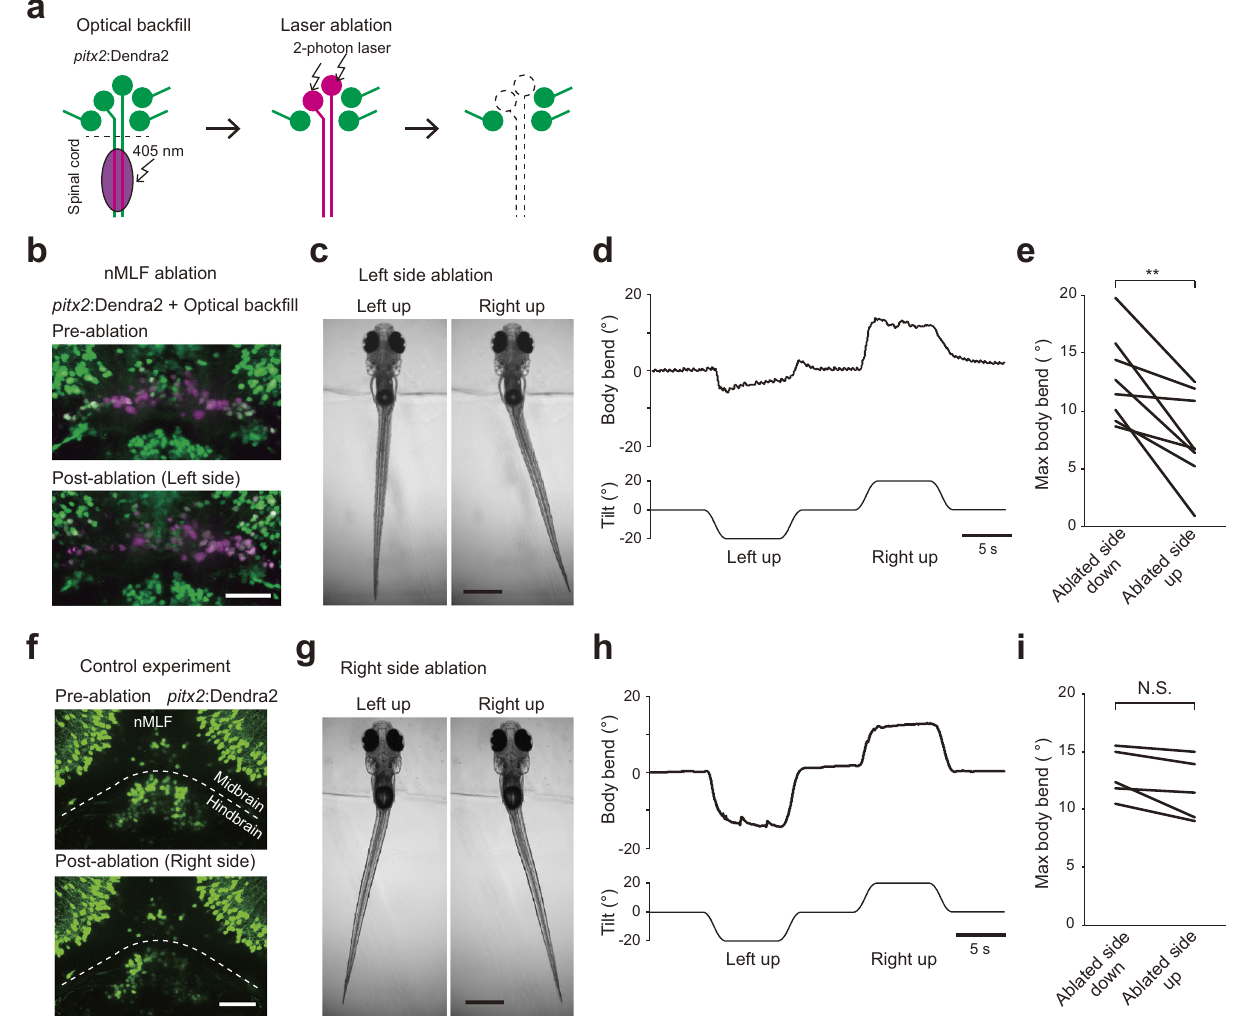
Fig. 7 | Ablation of nMLF neurons impairs the VBR. a – e Ablation of nMLF neu- rons. a Schematic showing optical back fi ll followed by laser ablation of nMLF neurons. b Confocal stacked images before (top) and after (bottom) laser ablation of nMLF neurons on the left side. c Behaviors of head-embedded fi sh during roll tilts. d Time course of the body bend angle in response to roll tilt. The same trial shownin c . e Pairwisecomparisonofmaximumbodybendanglesbetweenablated- side-downandablated-side-uptilts(eight fi sh;fourforeachsideablation).Average values of at least fi ve trials are shown for each fi sh. p =0.003 (two-sided